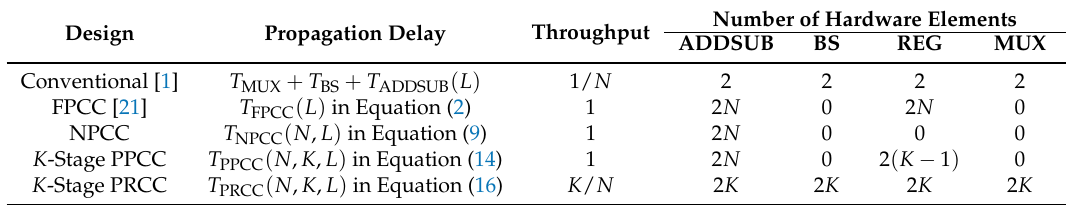
Table 3. Comparison of hardware and time complexities from different CORDIC architectures with N micro-rotations and L -bit